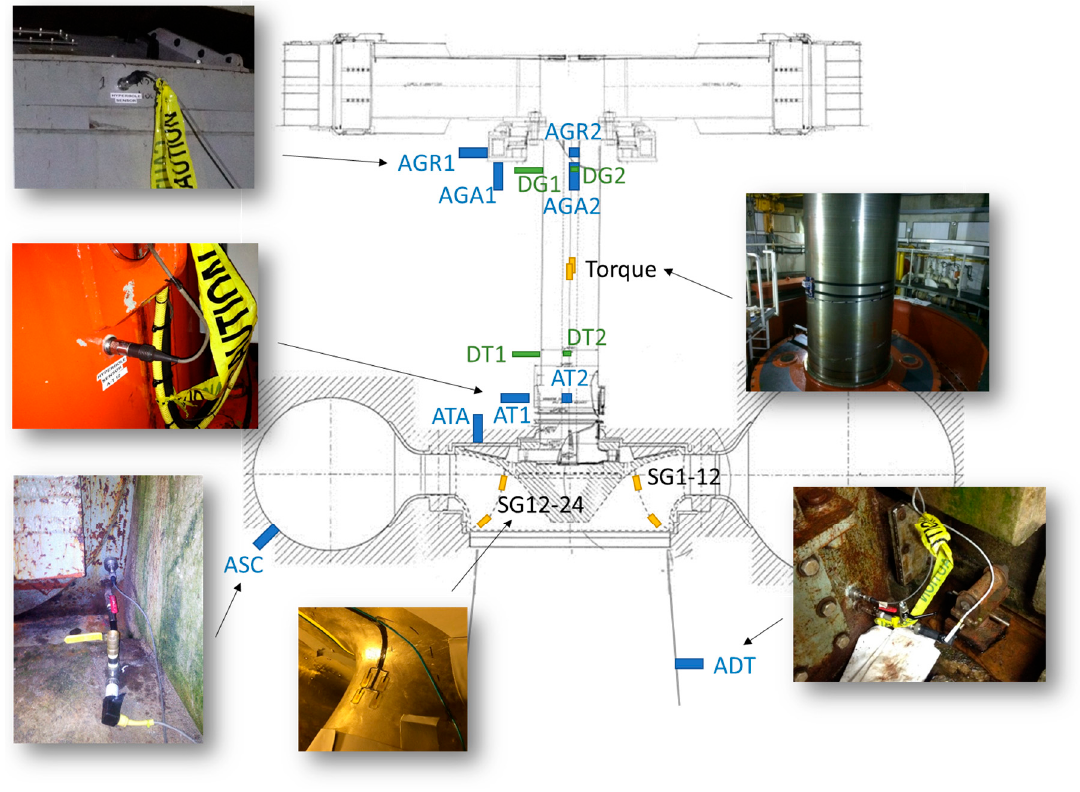
Figure 2. Sketch of the sensors installed in the mechanical system.